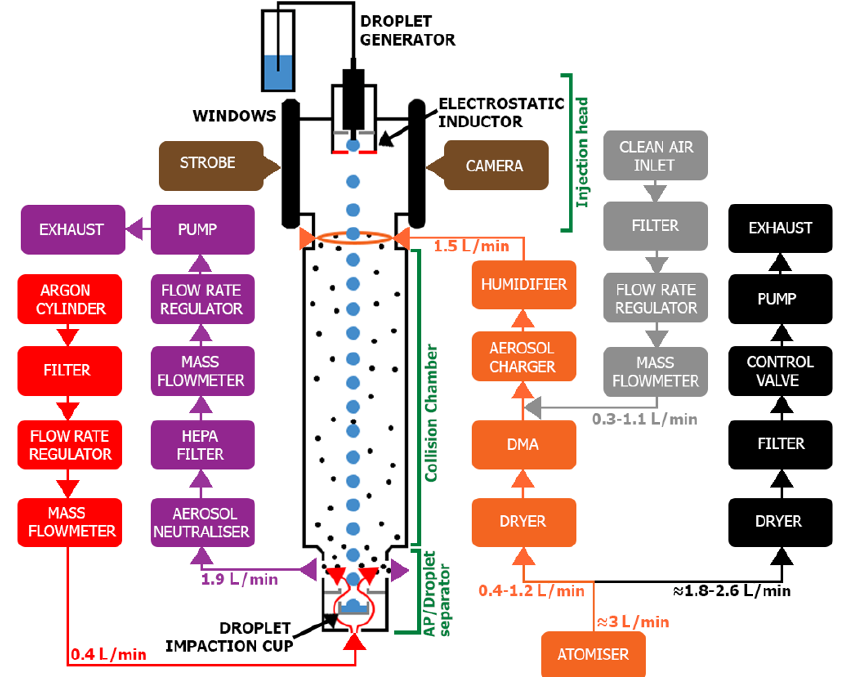
Figure 2. In-CASE setup to study the electric charges’ influence – adapted from Part I (Dépée et al., 2021). Colours represent different functions. Red represents upward argon flow against AP pollution in the droplet impaction cup. Purple represents AP (and Argon) evacuation toward the HEPA filter after neutralisation. Orange represents AP, generation, selection and charging. Black represents surplus evacuation and differential mobility analyser (DMA) flow rate control. Grey represents clean air adding for a constant flow rate at the AP charger’s inlet. Brown represents droplet radius